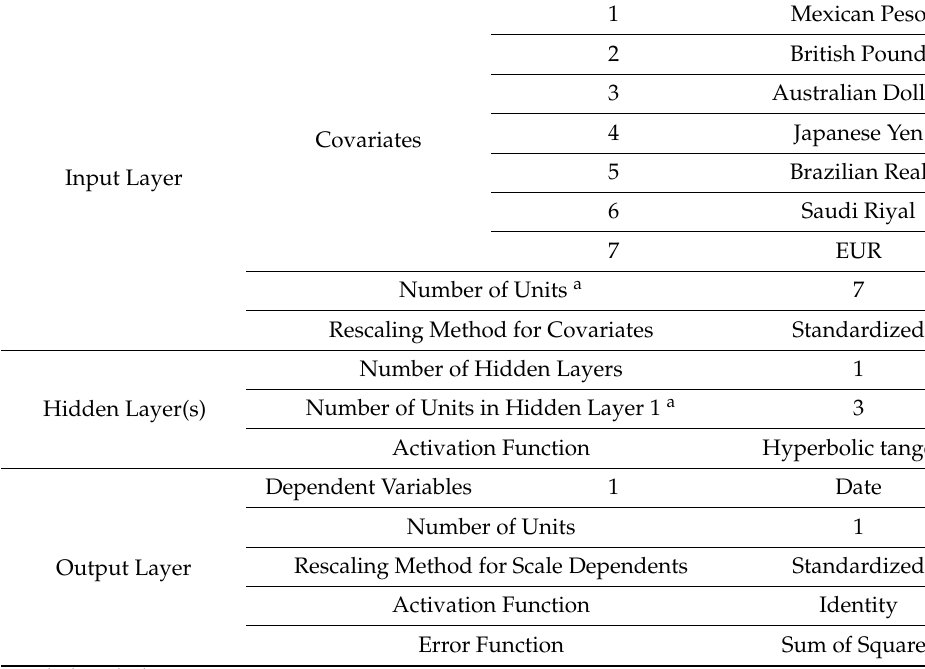
Table 13. Network